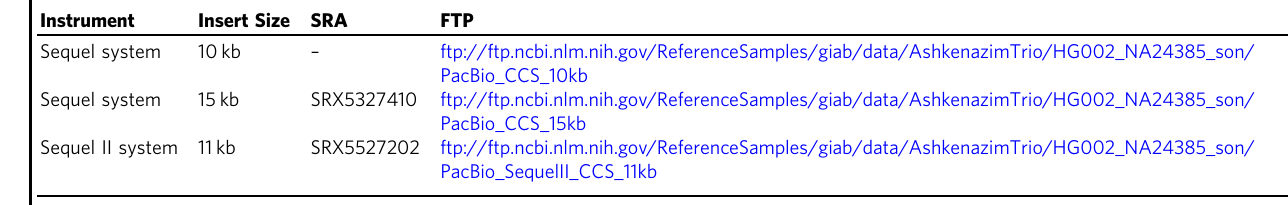
Table 1 PacBio HiFi reads used in evaluation of